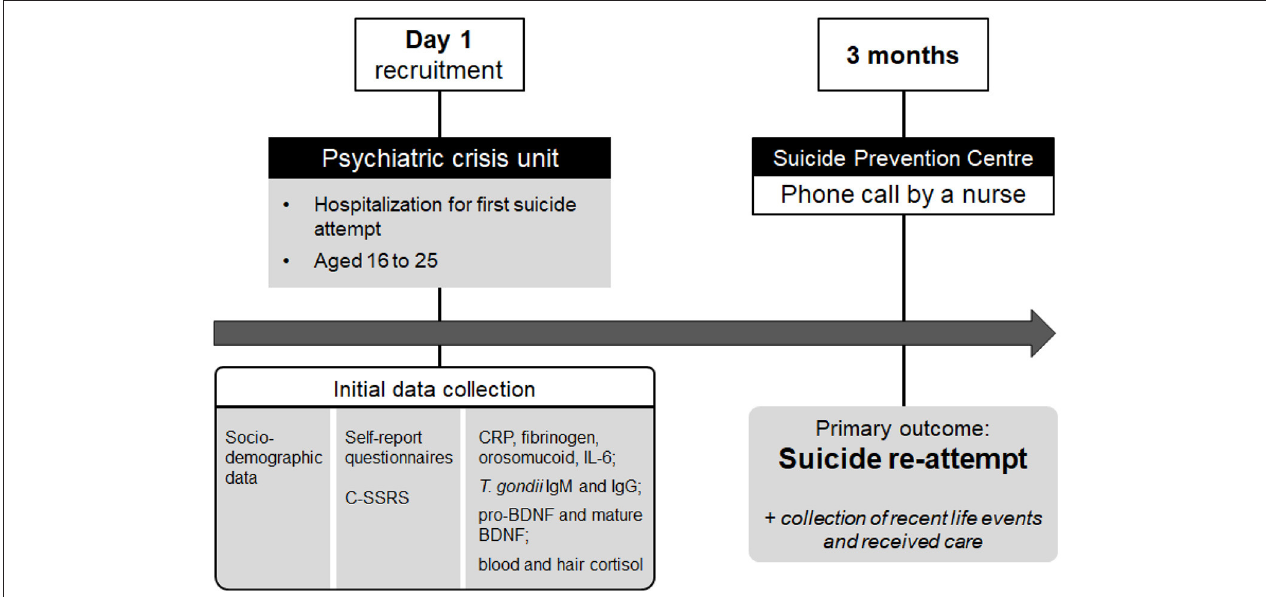
FIGURE 1 | Study design. On day 1, first-time suicide attempters aged 16 to 25 will be included in the SURAYA prospective cohort study upon their hospitalization in a psychiatric crisis unit. During their stay, socio-demographic, clinical and biological data will be collected. Three months later, participants will be contacted to retrieve the primary outcome: the presence or absence of a second suicide attempt (re-attempt) within the first 3 months. C-SSRS, Columbia Suicide Severity Rating Scale; CRP, C-Reactive Protein; BDNF, Brain-Derived Neurotrophic Factor; Ig, immunoglobulin; IL-6, interleukin-6; SURAYA, SUicide Re Attempts in Young Adults .